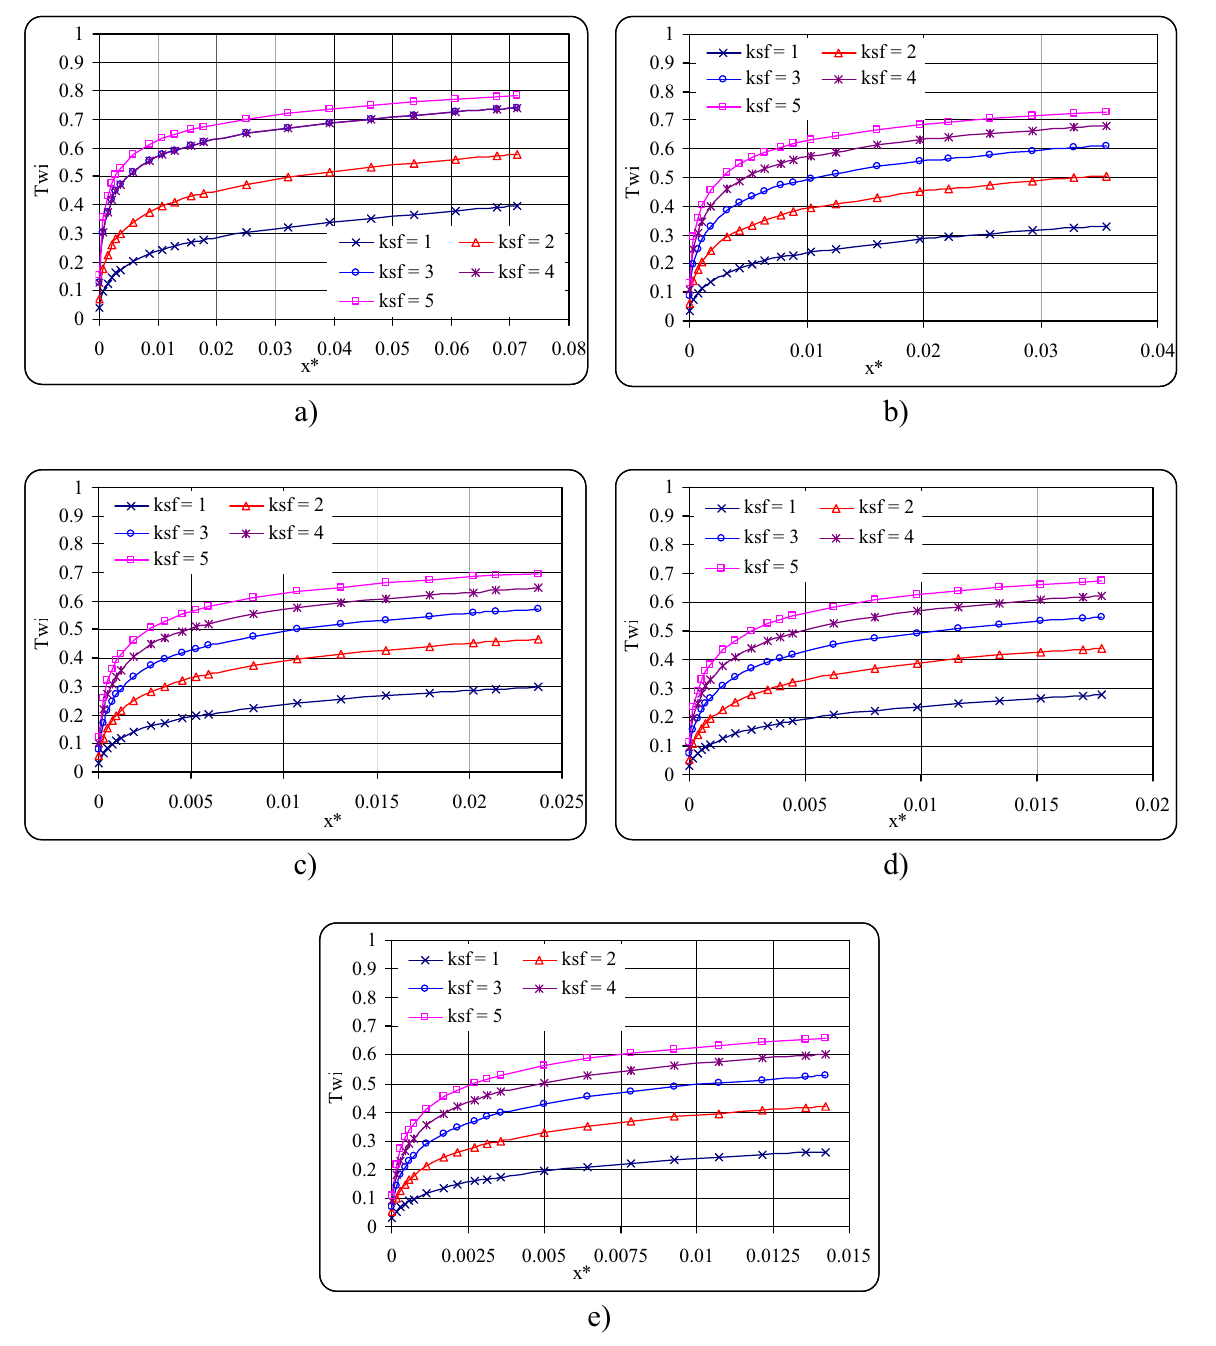
Figure 7: Relationship between dimensionless inside wall temperature vs dimensionless axial coordinate δ /R i = 1.25 and Pr = 7, with variable ksf ratio. ( a ) Re = 200, ( b ) Re = 400, ( c ) Re = 600, ( d ) Re = 800, and ( e ) Re =